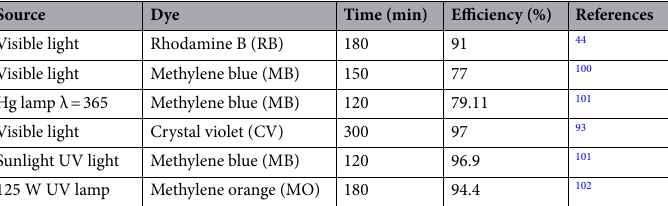
Table 3. Recently reported photocatalytic activity of various plant extract mediated CuO nanoparticles.